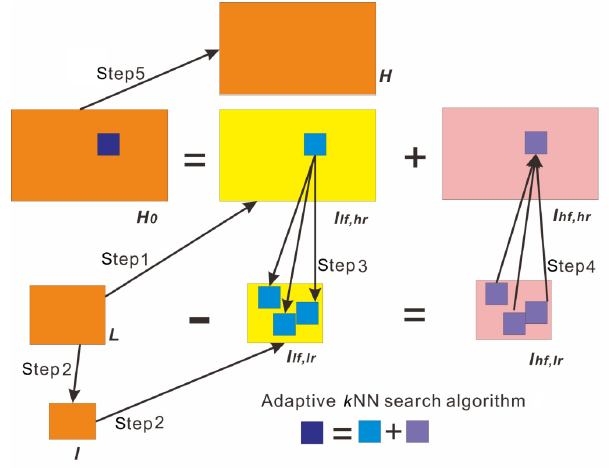
Fig. 2 Schematic diagram of the proposed approach. Steps 1 and 2 use feature-constrained polynomials, steps 3 and 4 are performed using adaptive k NN search, and step 5 uses iterative back-